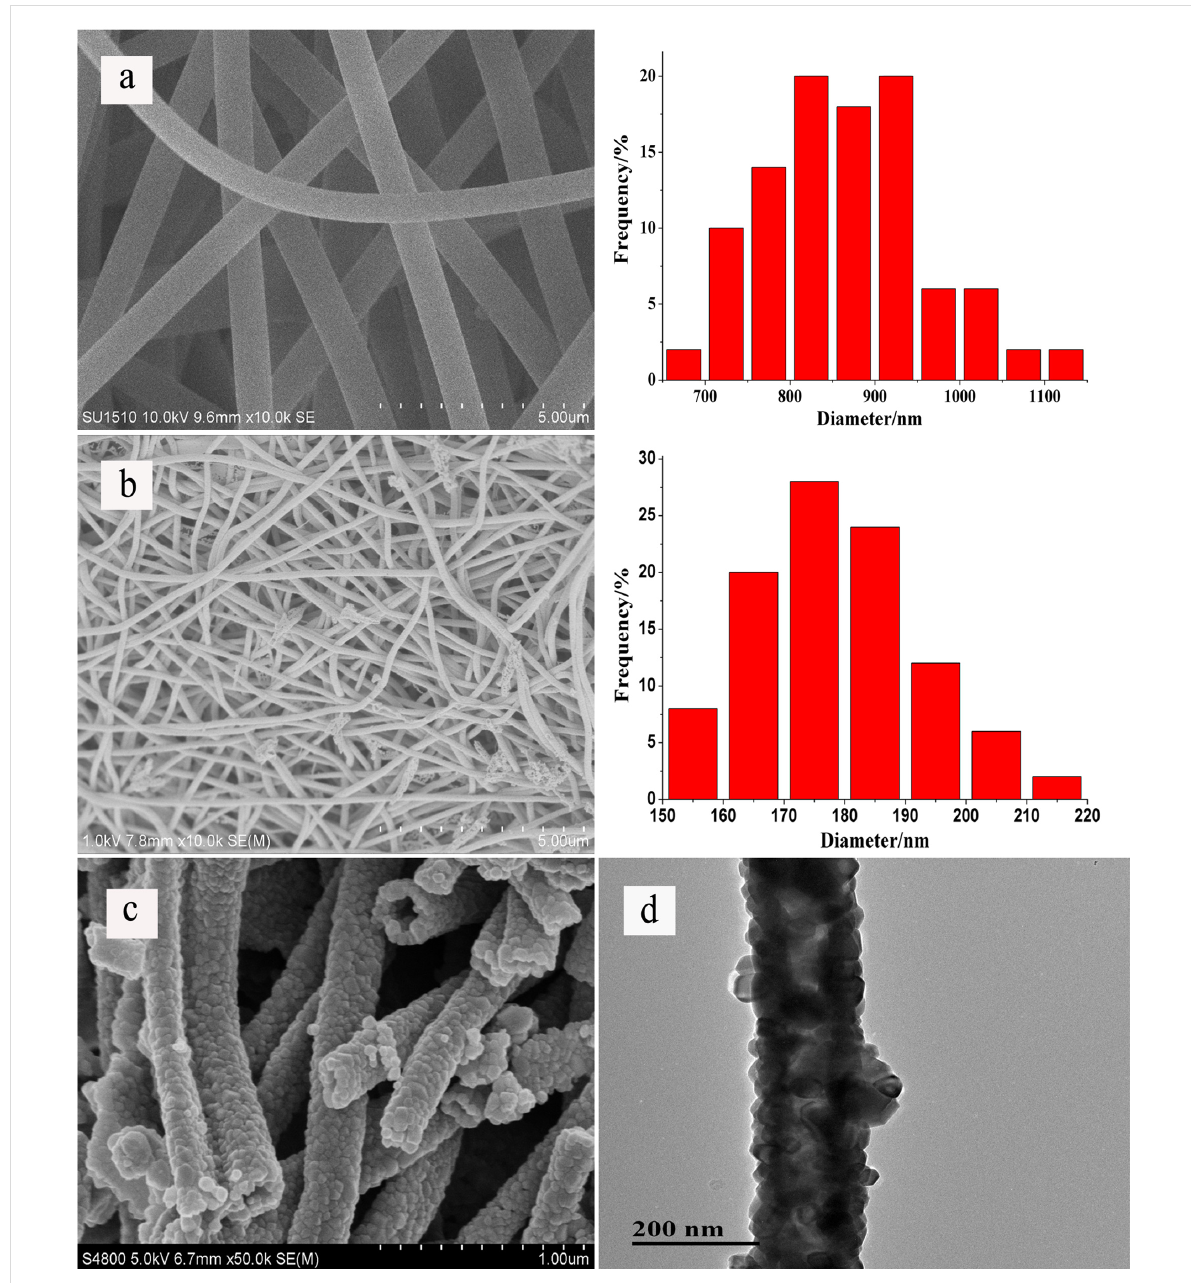
Figure 3: SEM images of (a) In(NO 3 ) 3 /PVP composite nanofibers (with diameter distributions), (b) In 2 O 3 nanofibers (with diameter distributions), (c) cross-section of In 2 O 3 nanofibers. (d) TEM image of In 2 O 3 nanofibers.